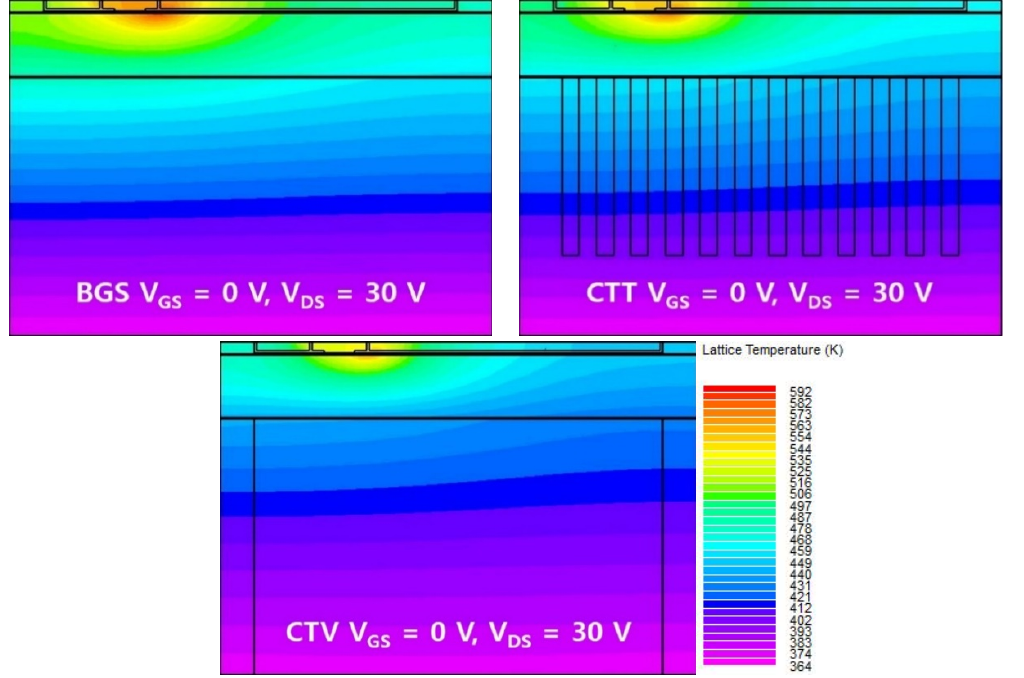
Figure 9. Temperature gradient profiles for the BGS, CTT, and CTV structures when V GS = 0 V and V DS = 30 V.